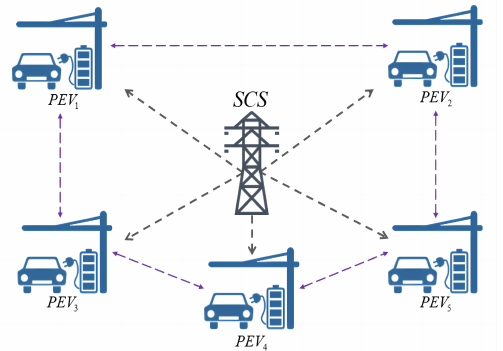
Figure 1. Mechanism of interaction between SCS and PEV combined with the aggregative